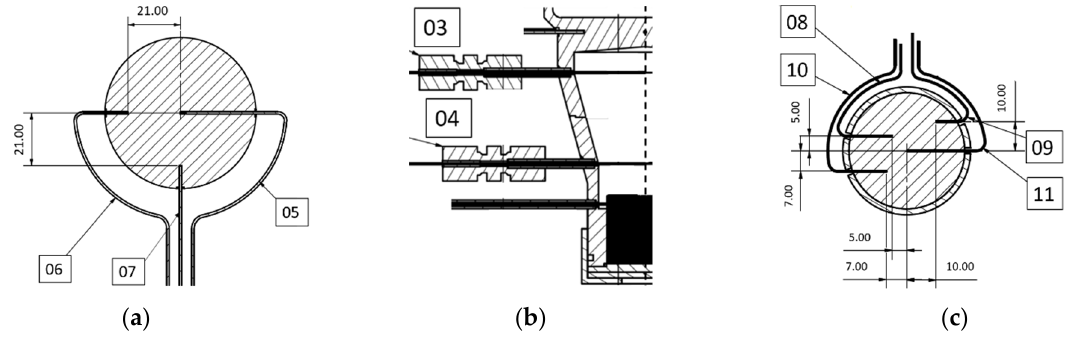
Figure 6. Temperature measurement arrangement of the FHP mock-up: ( a ) condenser wall temperature measurements (T-HP05:HP07); ( b ) vapor temperature measurements (T-HP03:HP04); ( c ) loaded surface temperature measurements (T-HP08:HP11).